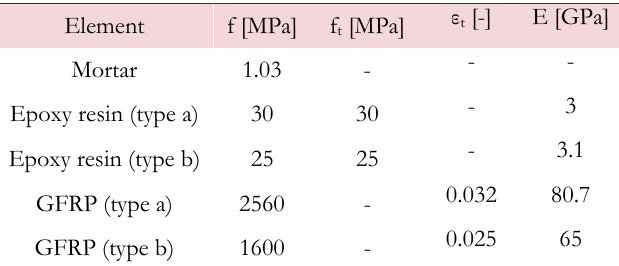
Table 1.A: Mechanical properties of constituents for the experimental tests [33].